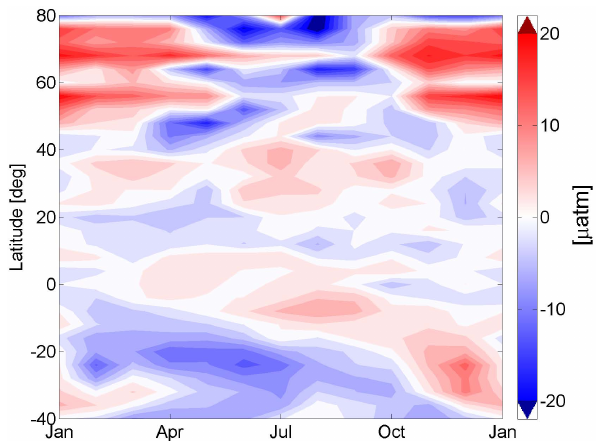
Fig. 9. Zonally averaged difference in the long-term mean seasonal cycle of the surface ocean p CO 2 between our neural network es- timates (this study), corrected to the year 2000 and those from the climatology of Takahashi et al. (2009). Positive differences indicate higher partial pressures of CO 2 in the neural network-based esti-